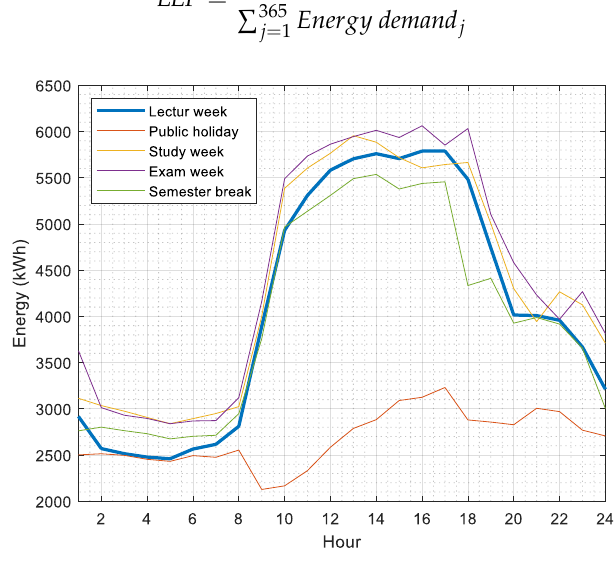
Figure 4. Proposed algorithm: (a) data calling and system specifications, (b) the deficit energy section, (c) the excess energy section and (d) optimum sizing options with cost calculations .